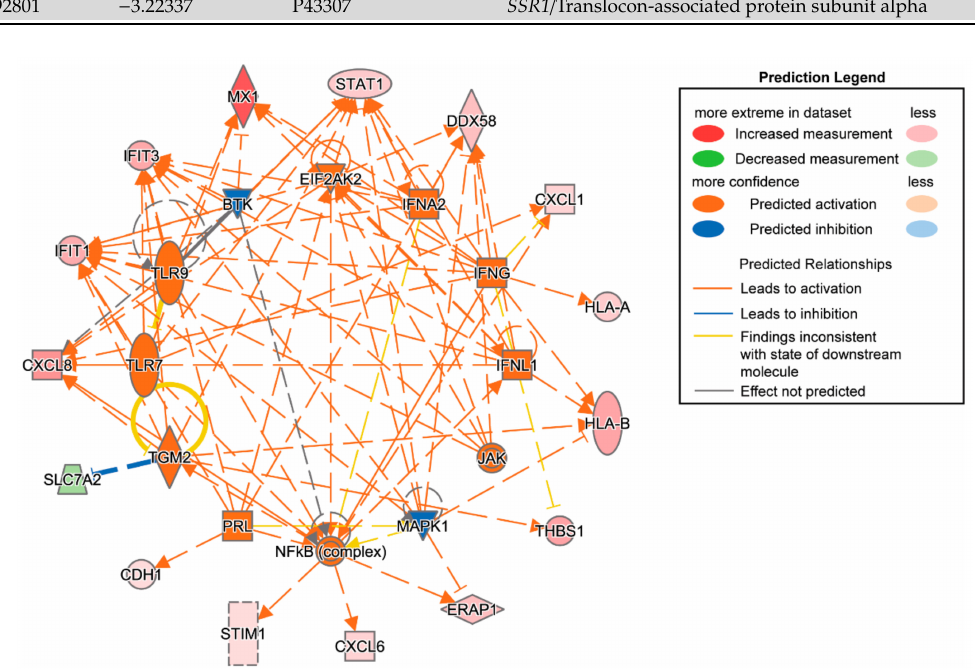
Figure 2. Ingenuity pathway analysis of SC- β cells infected with CVB4 for 48 h (proteomics). Inflammatory and type I IFN pathways were